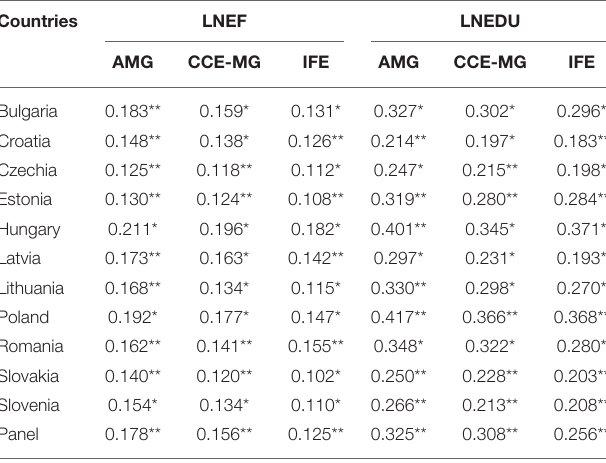
TABLE 6 | Results of cointegration coefficients estimation.